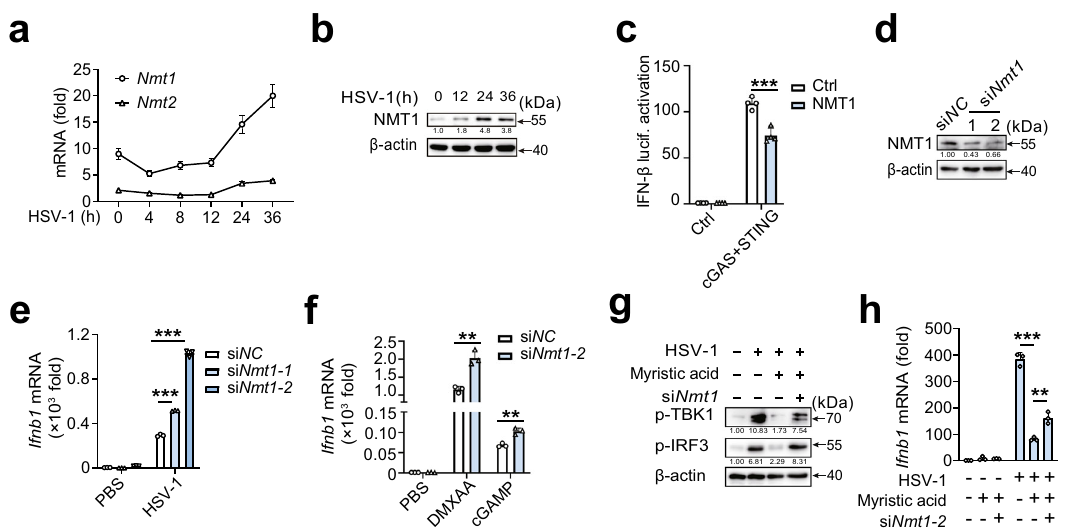
infection, DMXAA, or cGAMP stimulation, n =3 samples examined over 3 inde- pendent experiments. g Immunoblot analysis of p-TBK1 and p-IRF3 in PMs trans- fected with siNC or si Nmt1 , and then stimulated with myristic acid, followed by HSV-1 infection. h qPCR analysis of Ifnb1 mRNA in PMs transfected with siNC or si Nmt1 , and then stimulated with myristic acid, followed by HSV-1 infection, n =3 samples examined over 3 independent experiments. Statistical signi fi cance wasdetermined by unpaired two-sidedmultiple Student ’ s t-tests in( c ),( e ),( f ),and ( h ). Data are shown as mean±standard deviation (SD) or typical photographs and arerepresentativeofthreebiologicalindependentexperimentswithsimilarresults.